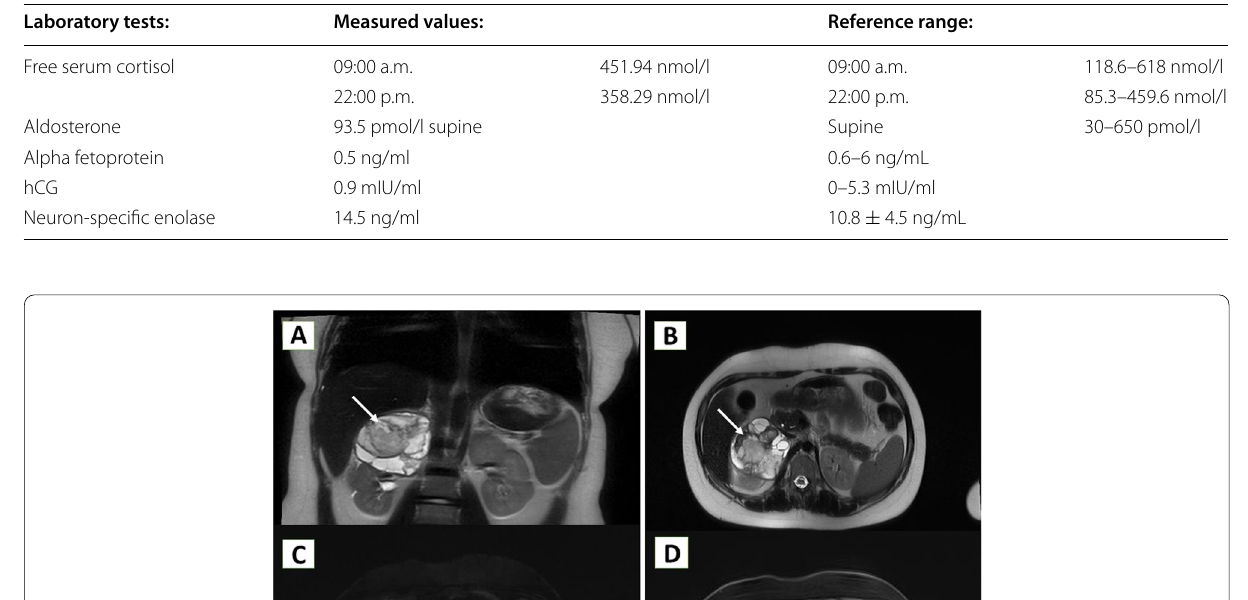
Table 2 Additional hormonal analysis 1 month after the initial diagnosis